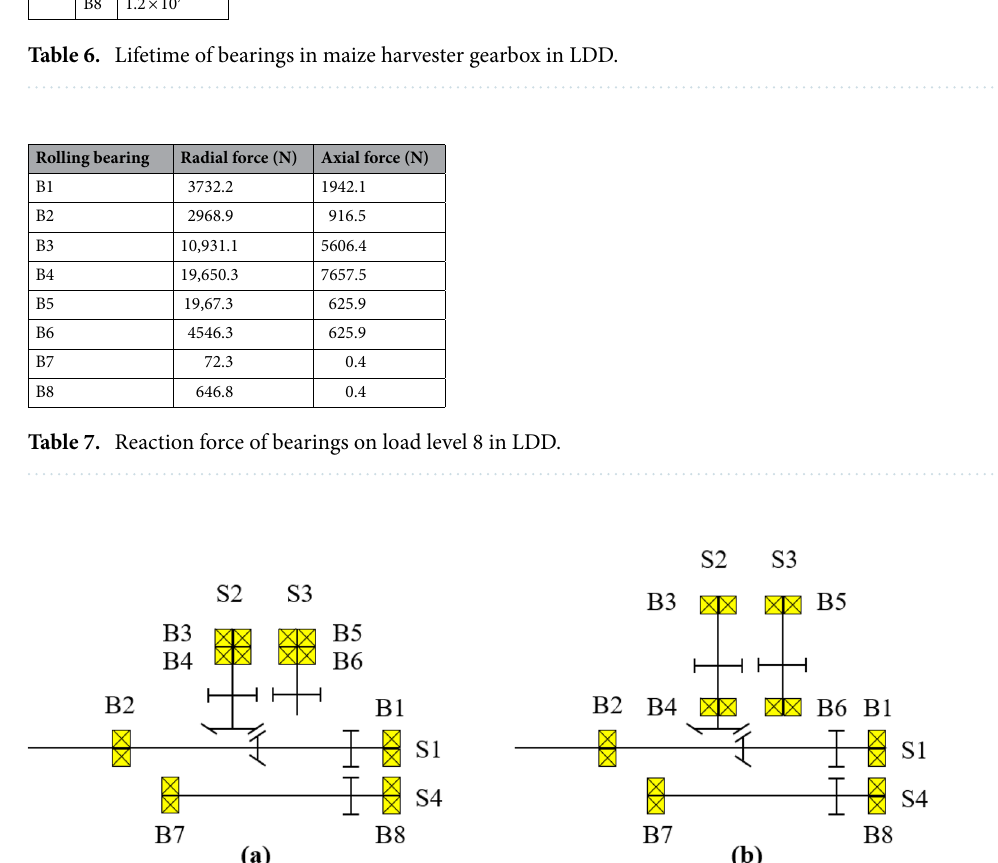
Figure 5. Change in bearing arrangement according to design modification of gearbox: ( a ) Before and ( b ) after design